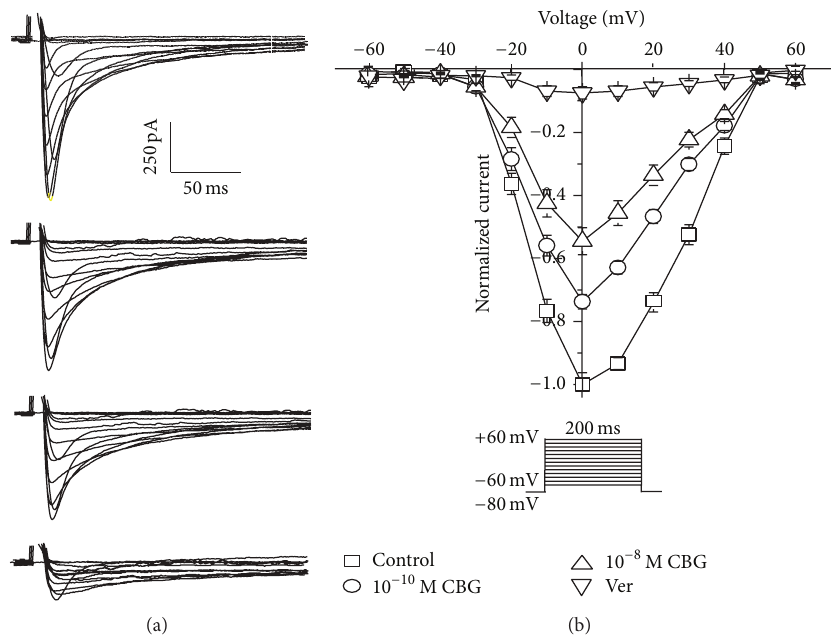
Figure4:EffectsofCBGon I-V curveof 𝐼 .(a)-(b):Exemplarytraces(a)andpooleddata(b)showeffectsofCBGatdifferentconcentrations Ca-L on the I-V relationship. Data are presented as means ± S.E.M. ( 𝑛 = 8 cells).